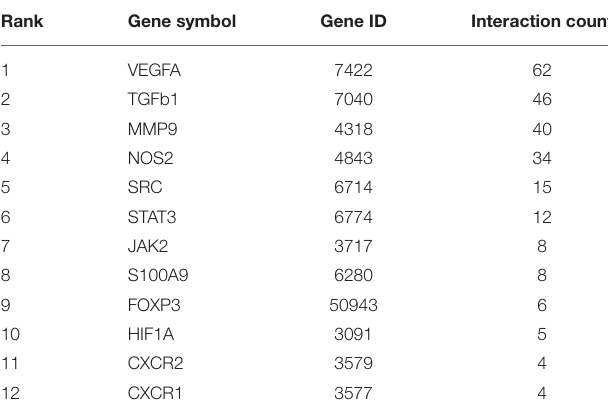
TABLE 4 | Targets genes of E 2 , VEGF, and MDSC identified by CTD network.